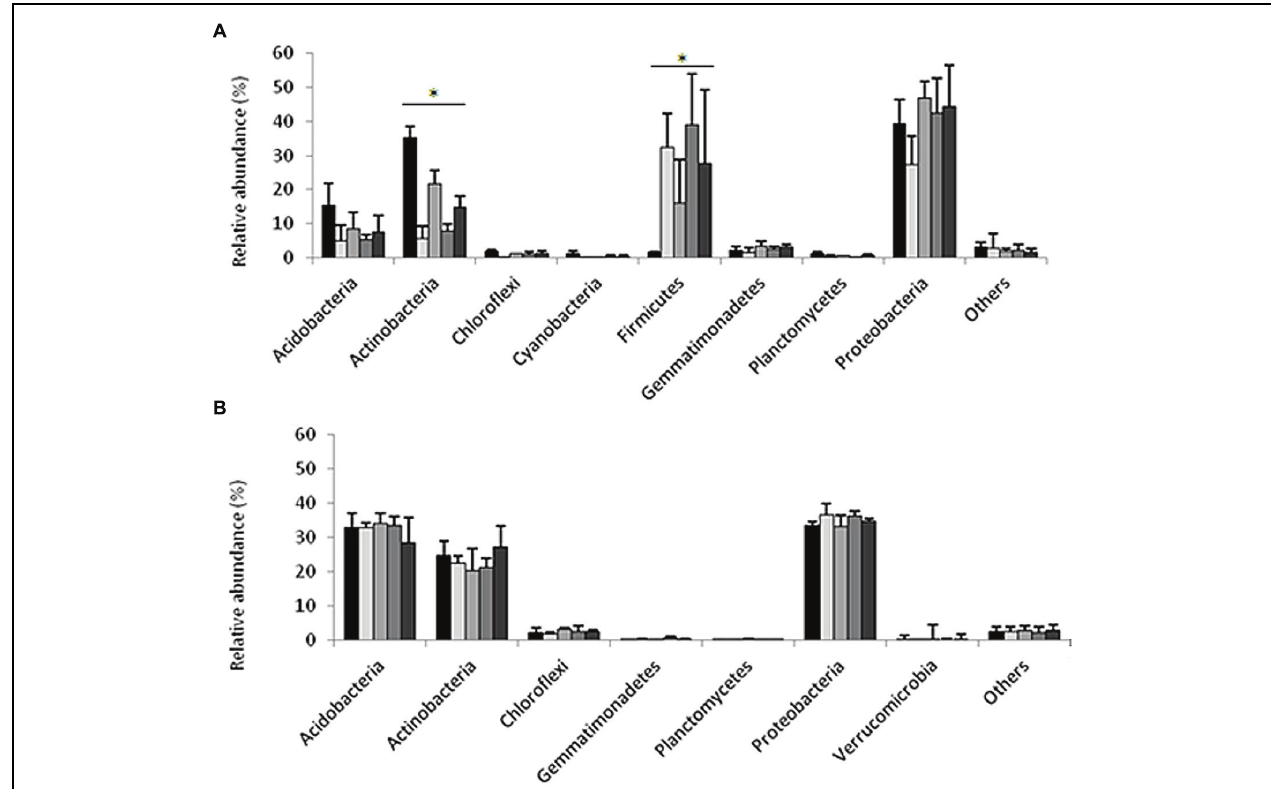
FIGURE 2 | Relative abundance of dominant phyla generated by pyrosequencing of 16S rRNA gene amplicons from the sandy loam (A), and clay (B) soil microcosms. The first bar in each phylum indicates samples taken at time zero; the second and third bars indicate samples taken at 7 days, non-amended and antibiotic-amended treatments respectively; and the fourth and fifth bars indicate samples taken at 14 days, control- and antibiotic-amended treatments respectively. Asterisks indicate significances differences between treatments for a specific phylum. Bars represent average standard deviations of each treatment.